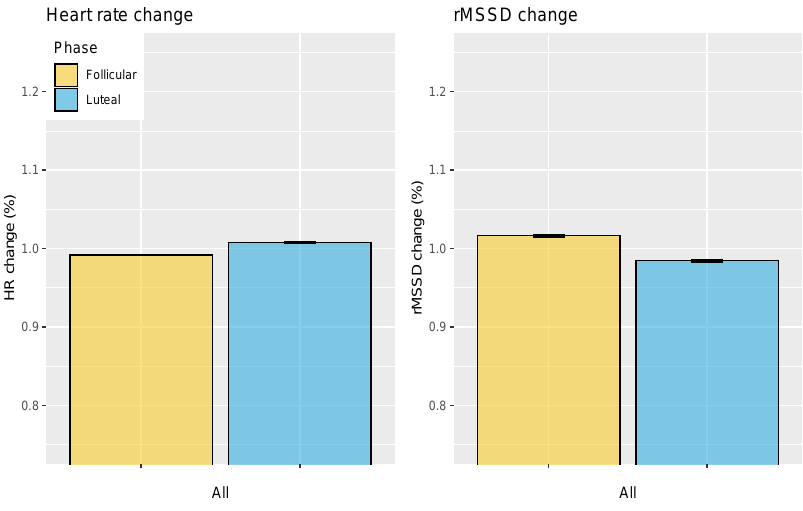
Figure 11. Relation between HR, HRV, and the menstrual cycle. In particular, the difference between the follicular and luteal phases, with respect to an user’s average heart rate and HRV, is reported. In terms of responses to alcohol intake, overall, across all age groups and partic- ipants, heart rate increased by 6% after high alcohol intake ( p < 0.05, d = 0.97, effect size = large), while rMSSD reduced by 12% after high alcohol intake ( p < 0.05, d = 0.55, effect size = moderate; see Figure 12). A similar response was found in male and female users, while a decrease in the sensitivity to the stressor was shown with increasing